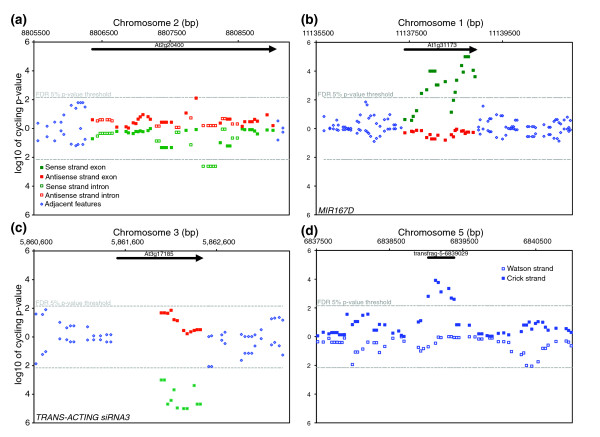
The Arabidopsis tiling arrays portray several interesting classes of circadian behavior in the genome. Each symbol is a feature on the tilling array showing location in the genome (x-axis) and significance of the spectral analysis (y-axis) for (a) AT2G20400, (b) MIR167, (c) TRANS-ACTING siRNA3, and (d) transfrag-5-6839029. The top half of each panel displays the Watson strand and the bottom half the Crick strand. Individual features that exceed the false discovery rate 5% p-value threshold (-) are considered to have a circadian rhythm.